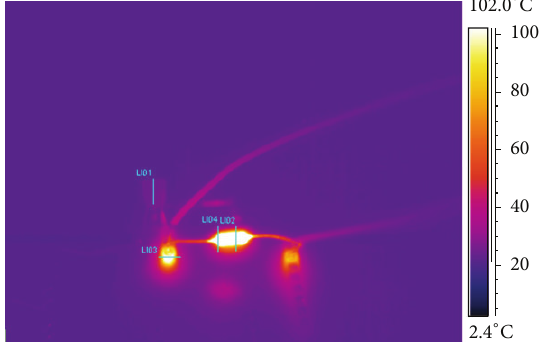
Figure 3: Thermogram of the resistor in electronic circuit with pulse excitation.